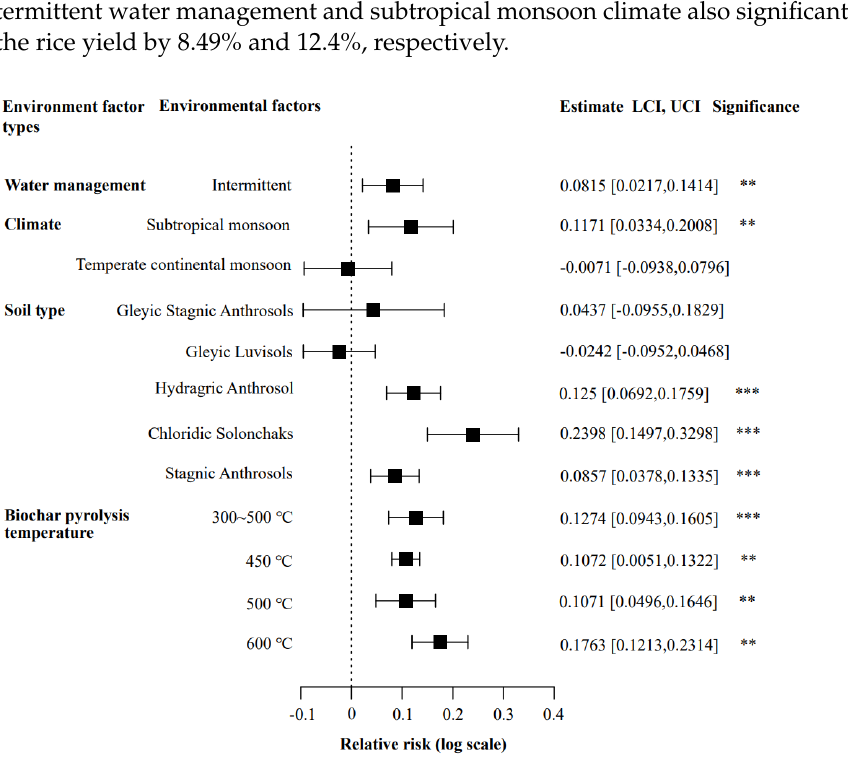
Figure 2. Estimated impact of key factors of heterogeneity on rice yield in biochar-amended soil. Estimate stands for mean effect size; ** and *** indicate statistical significance levels at 0.01 and 0.001, respectively, for the estimate; values in brackets mean LCI (the bottom of 95% confidence interval) and UCI (the ceiling of 95% confidence interval). Treatments explored but without appearance in this figure represent no effect size.